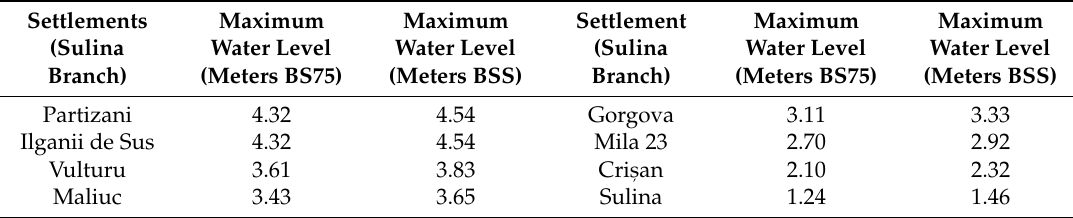
Table 3. Maximum water levels for the year 2010 in meters Black Sea 75 (BS75) and the Black Sea Sulina (BSS) of the Danube near the settlements.